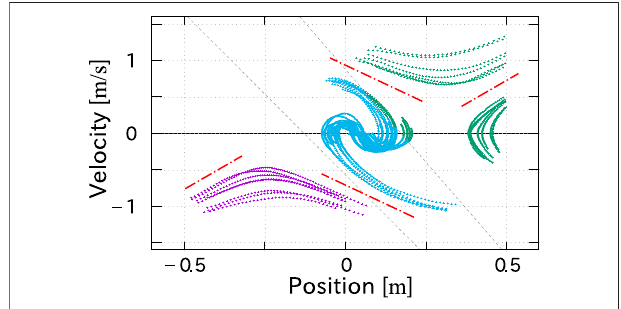
FIGURE 8 | Trajectories of standing motions in x - _ x space. The subject took the fi nal posture of the step-and-brake motion with 45 cm stride. The clustering technique proposed in (Sugihara et al., 2022) divided the trajectories into three segments by two black dashed lines. The asymptotic lines (red chained lines) are